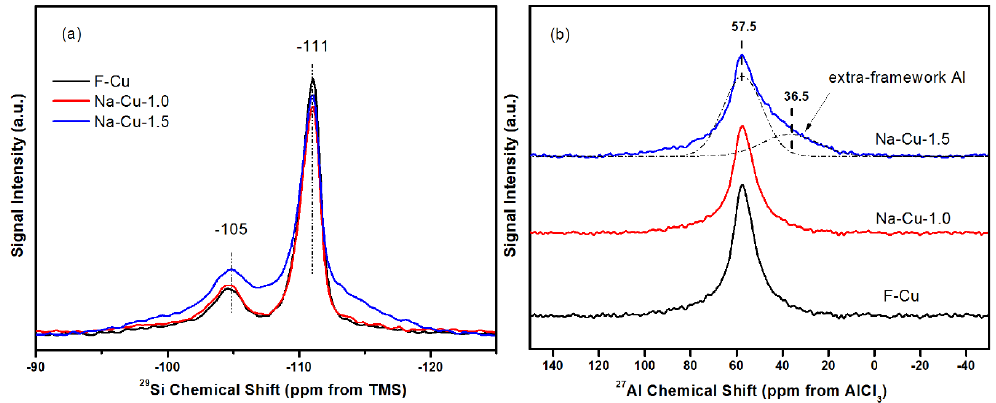
Figure 10. ( a ) 29 Si NMR and ( b ) 27 Al NMR spectra of F-Cu, Na-Cu-1.0, and Na-Cu-1.5.